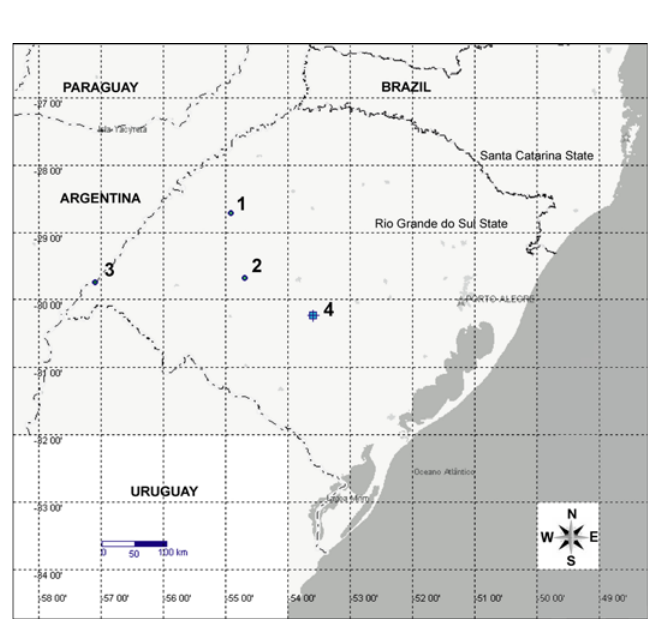
Figure 1 . Range distribution of Leptodactylus chaquensis in the state of Rio Grande do Sul, Brazil. 1, municipality of Bossoroca, Missões region; 2, municipality of São Vicente do Sul, Depressão Central region; 3, municipality of Uruguaiana, Campanha region; 4, municipality of São Sepé, Serra do Sudeste region (new